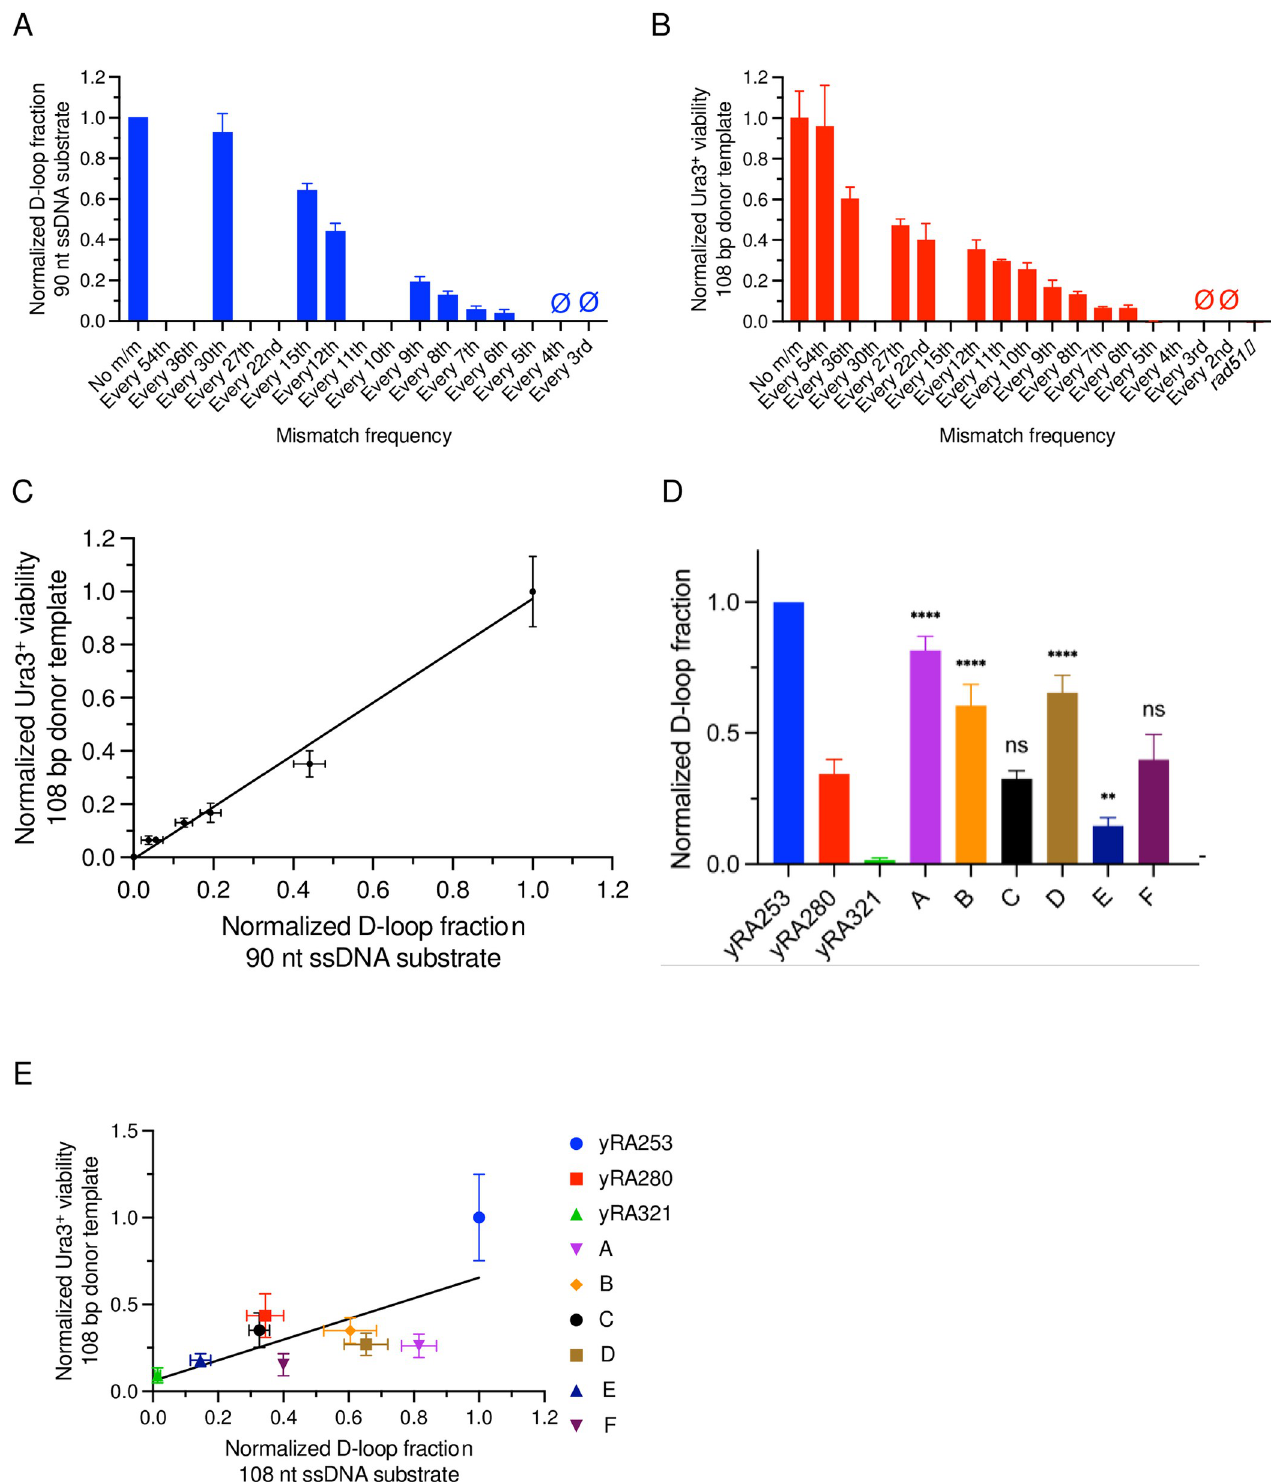
Fig 4. Comparison of BIR with in vitro D-loop formation. A. Normalized D-loop fraction, using 90-nt ssDNA substrates containing only evenly-distributed mismatches. B. Normalized Ura3 + viability (reproduced from [17]), using 108-bp donor DNA templates containing only evenly-distributed mismatches. C. Correlation between normalized Ura3 + viability and normalized D-loop fraction, using 108-bp donor templates and 90-nt ssDNA substrates, respectively, containing only evenly-distributed mismatches. D. Normalized D-loop fraction of 108-nt ssDNA substrates containing both evenly- and unevenly-distributed